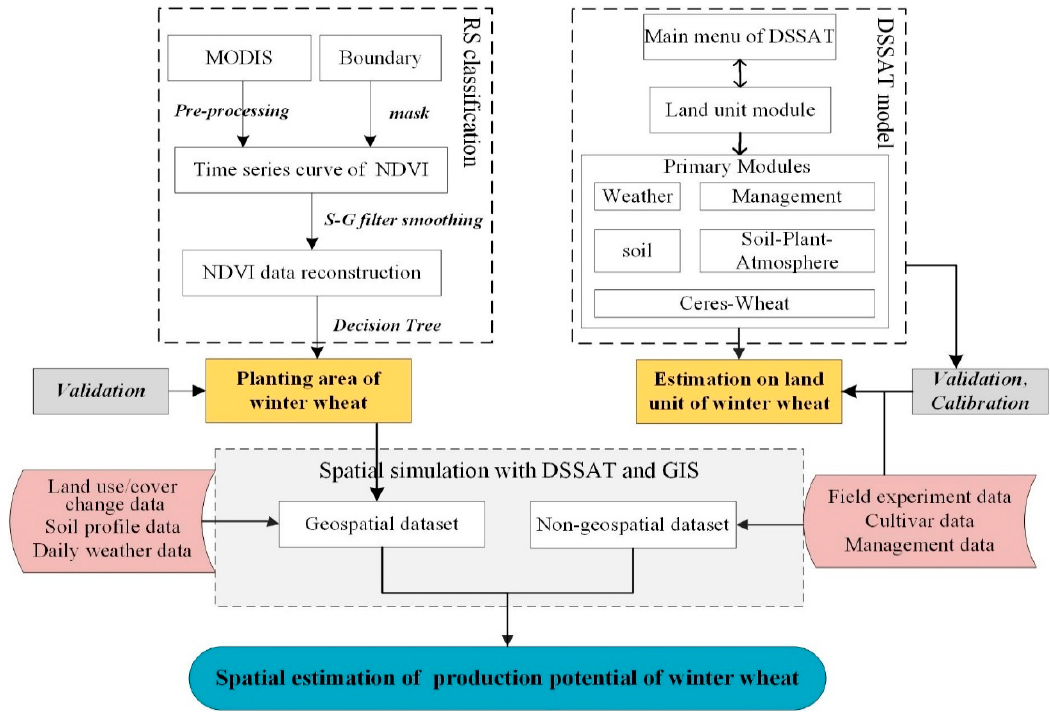
Figure 2. Technical flowchart.